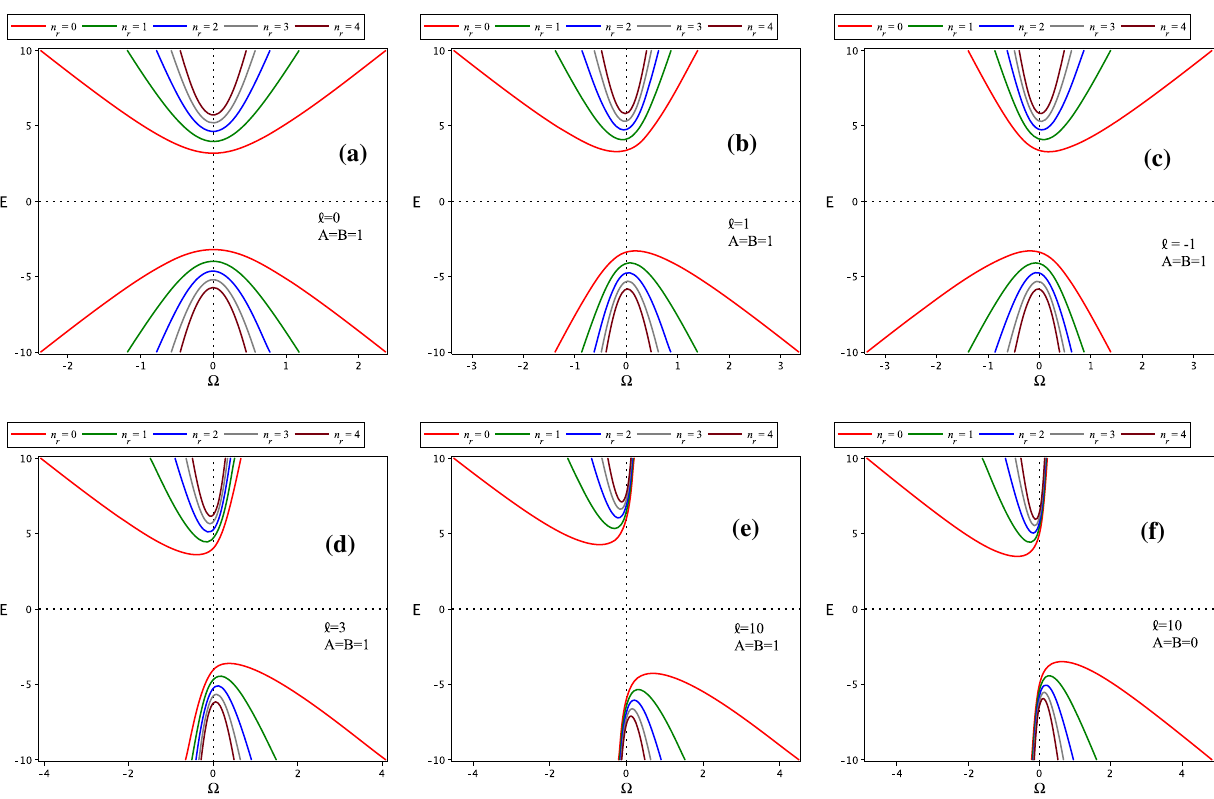
(cid:13) = 0 , 1 , − 1 , 3 , 10, respectively. In f we show the KG-oscillator ener- Fig. 2 For η = m = 1 we show E n of (23) against the vorticity r ,(cid:13) parameter (cid:2) at n r = 0 , 1 , 2 , 3 , 4. In a – e we show the KG-oscillator gies without the Cornell confinement (14) (i.e., A = B = 0) at (cid:13) = 10 energies with the Cornell confinement (14) (i.e., A = B = 1) for